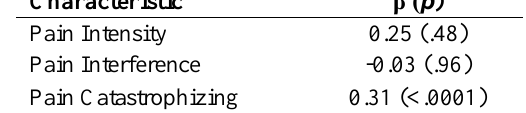
Table 3. Multivariable regression for factors associated with mobility apprehension Characteristic Pain